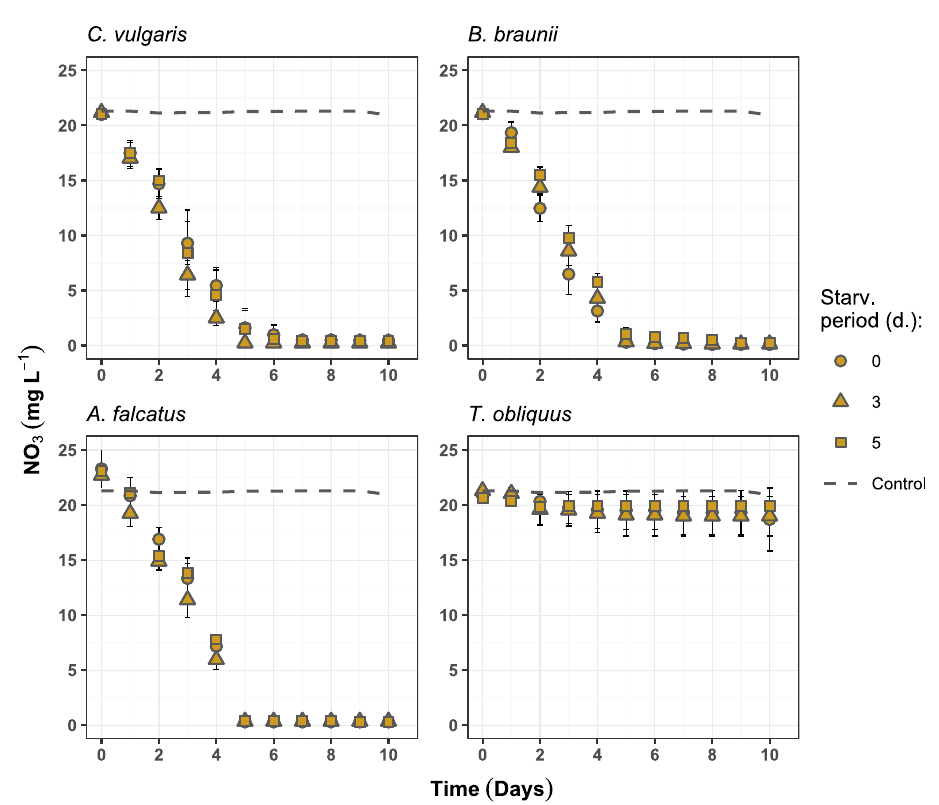
Figure 3. Nitrate concentration changes over time in the experiment batches for C. vulgaris , B. braunii , A. falcatus , and T. obliquus (means ± SD, n =